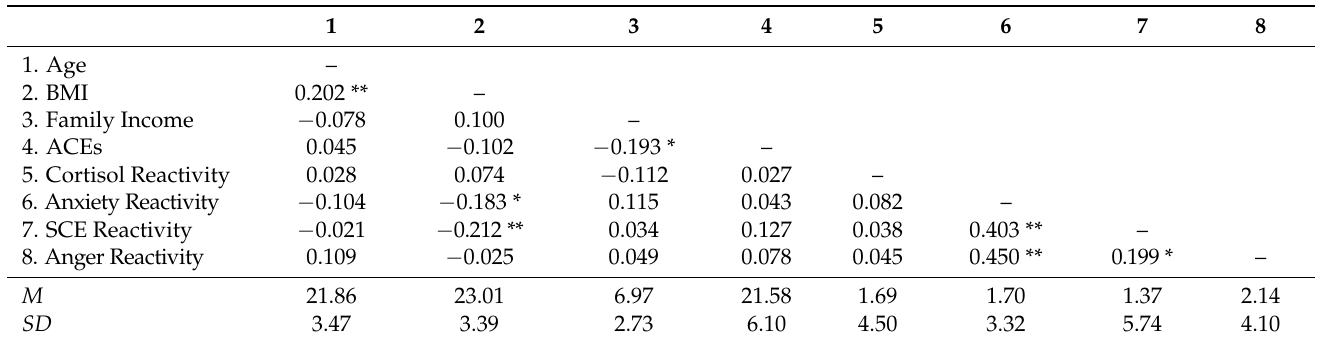
Table 1. Descriptive Statistics and Bivariate Correlations between Sample Characteristics and Out- comes of Interest.